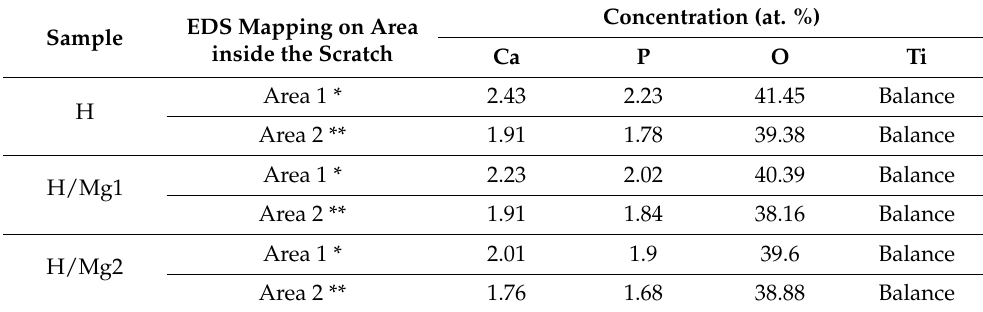
Figure 10. SEM images and EDS mapping within the scratches of all coatings. Table 6. Chemical composition within the scratches imprint of all investigated